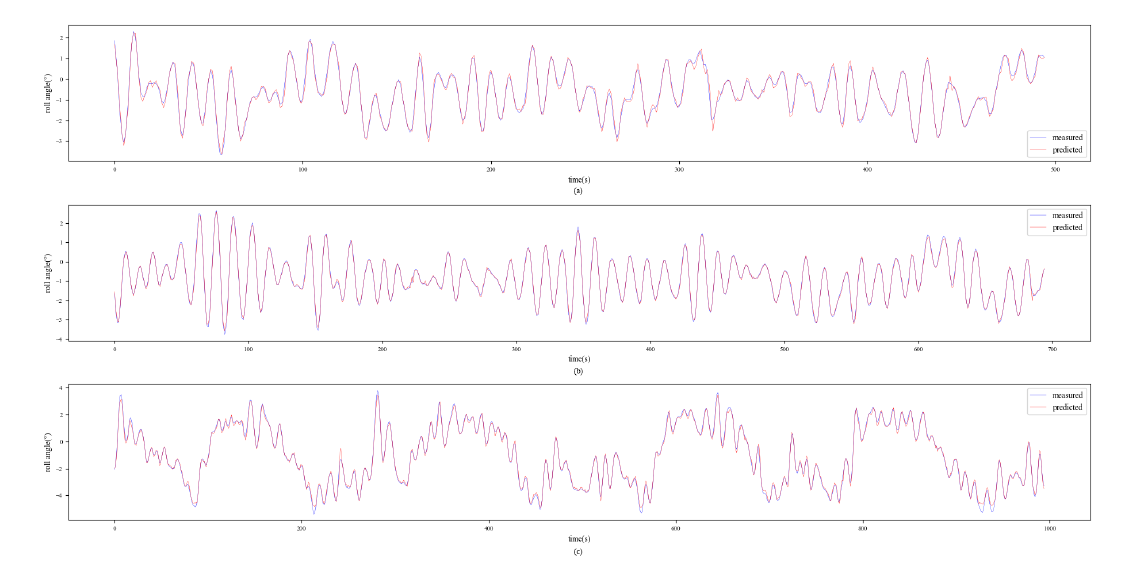
Figure 5. The trajectory history of “JingHai-VI” test sets: ( a ) test set-1, ( b ) test set-2, and ( c ) test set-3.